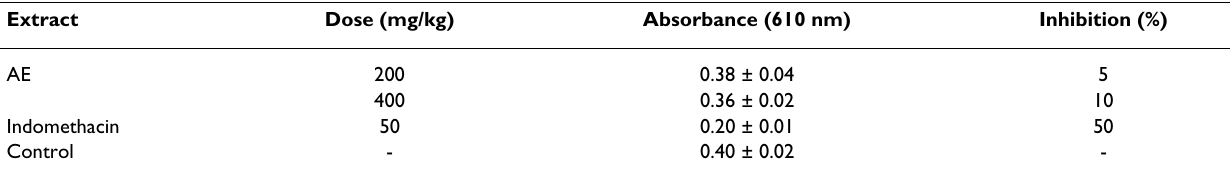
Table 5: Effect of extract on acetic acid-induced vascular permeability Extract